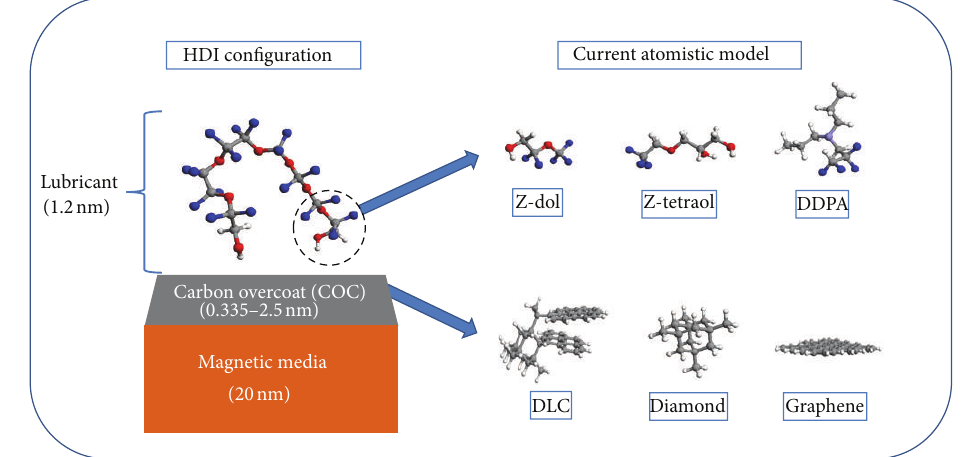
Figure 2: Model PFPE and COC materials for atomistic scale